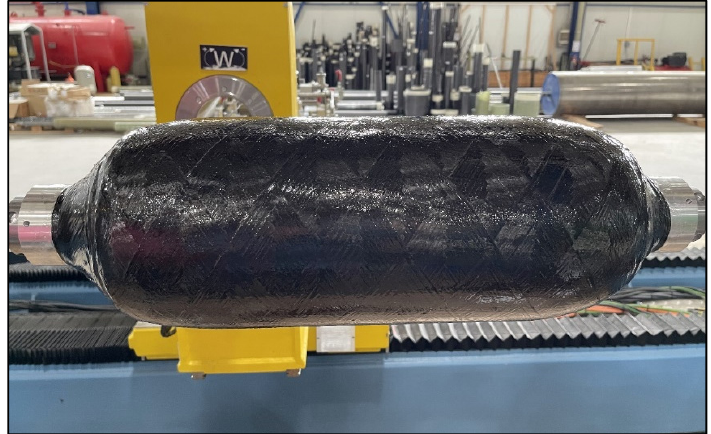
Figure 1. CFRP tank during the filament winding.